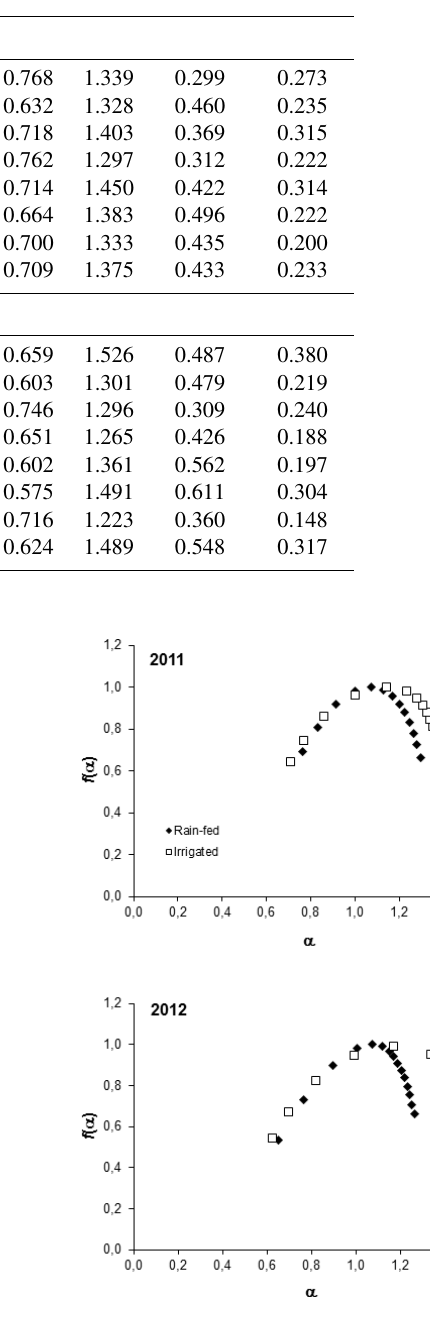
Figure 5. Singularity spectra for soil water content averaged from 20 to 60cm depth for rain-fed and irrigation treatments in 2011 and